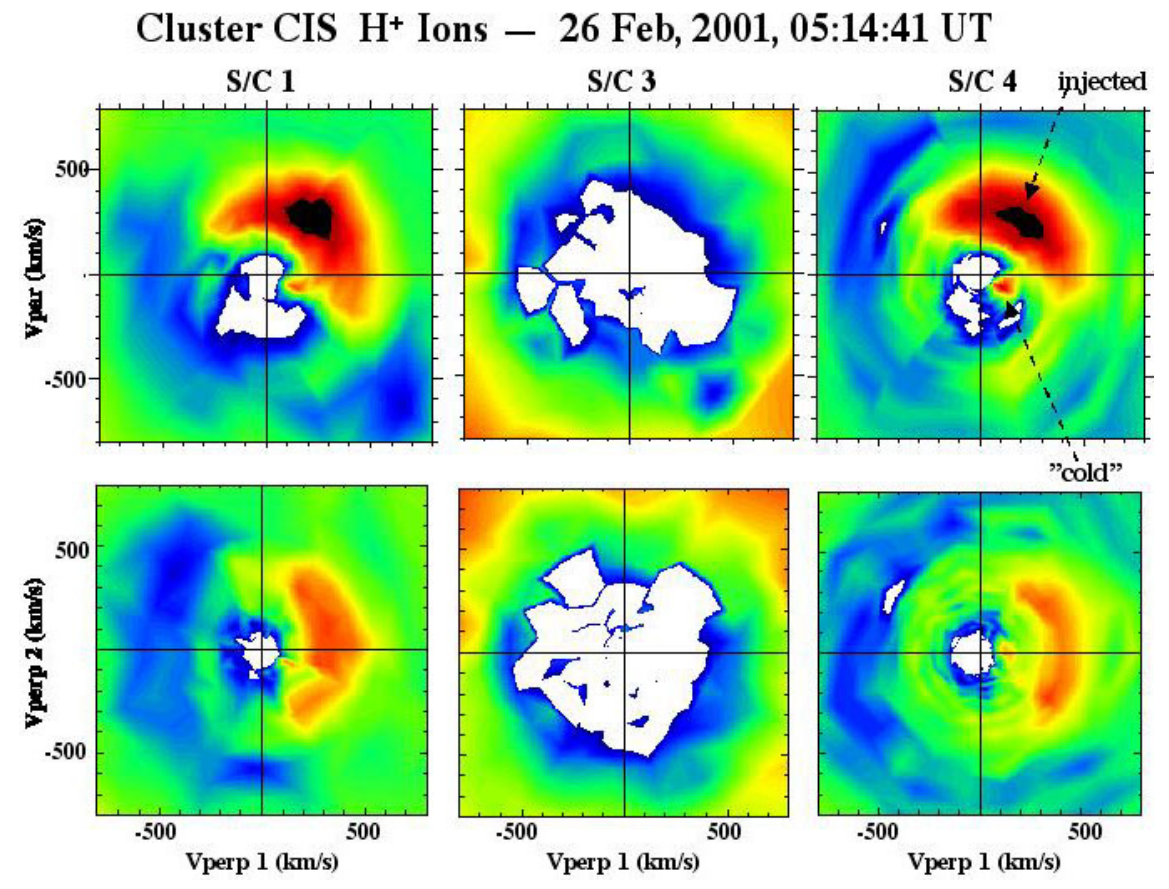
Fig. 7. H + velocity distribution, parallel and perpendicular to the magnetic field, for the PTE on 26 February 2001 described in Fig. 2. Notice the difference in transverse velocity for the injected magnetosheath plasma and the local “cold”